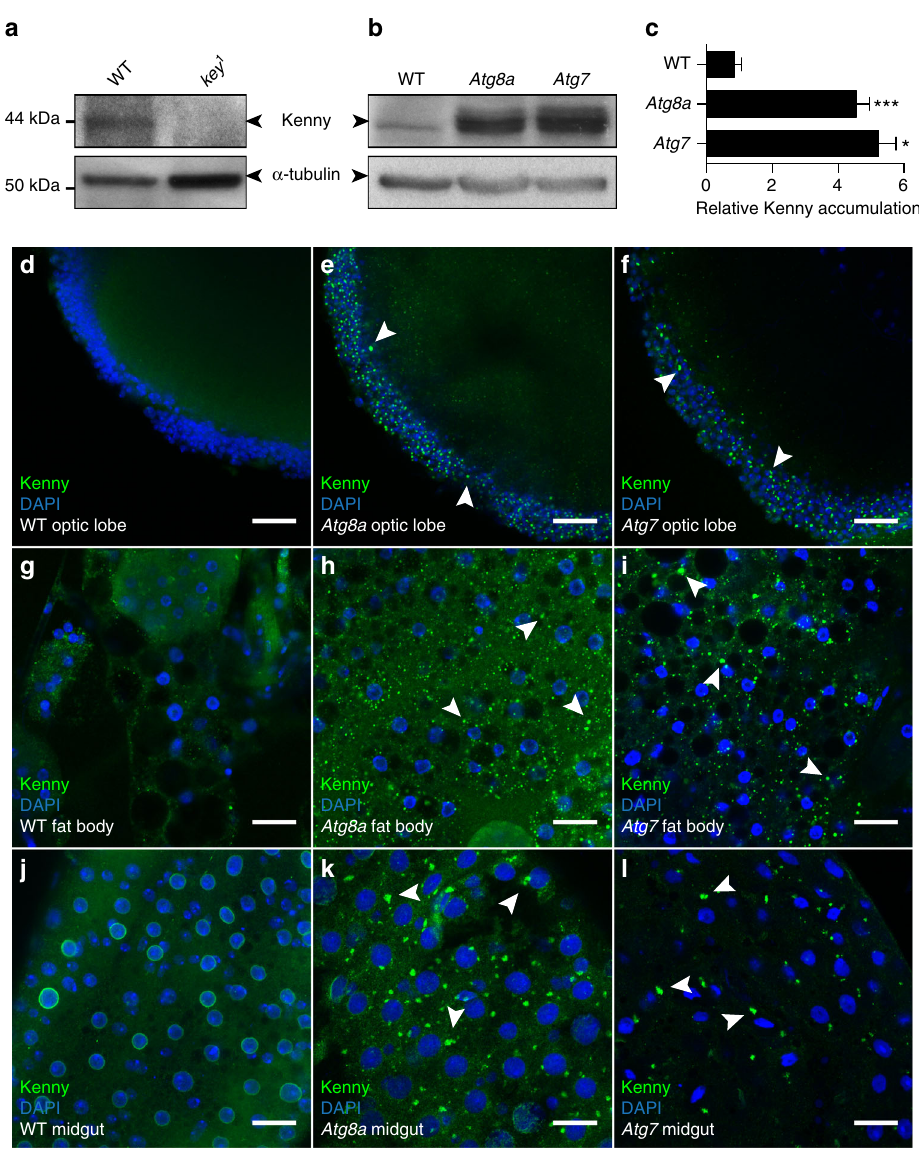
Fig. 3 Endogenous Kenny protein accumulates in Atg8a and Atg7 mutant fl ies. a , b Full body lysates from wild-type (WT) and kenny mutant ( key 1 ) fl ies a or Atg8a and Atg7 mutant fl ies b were subjected to SDS-PAGE and immunoblotting for Kenny. Tubulin was used as loading control. c Quanti fi cation of the quantity of Kenny protein normalized to tubulin. Bar chart shows means ± s.d. Statistical signi fi cance was determined using one-way ANOVA, * P < 0.05, *** P < 0.001. d – l Confocal images from adult brains d – f , fat bodies g – i and midguts j – l from WT d , g , j , Atg8a e , h , k and Atg7 f , i , l mutant fl ies stained for Kenny (green) and DNA (blue). Arrowheads show some Kenny aggregates. Scale bars are 20 µ